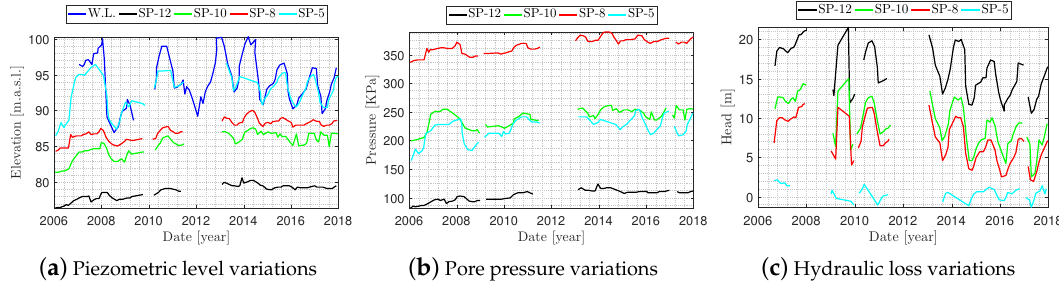
Figure 5. Recorded data by Casagrande piezometers at Section #2.